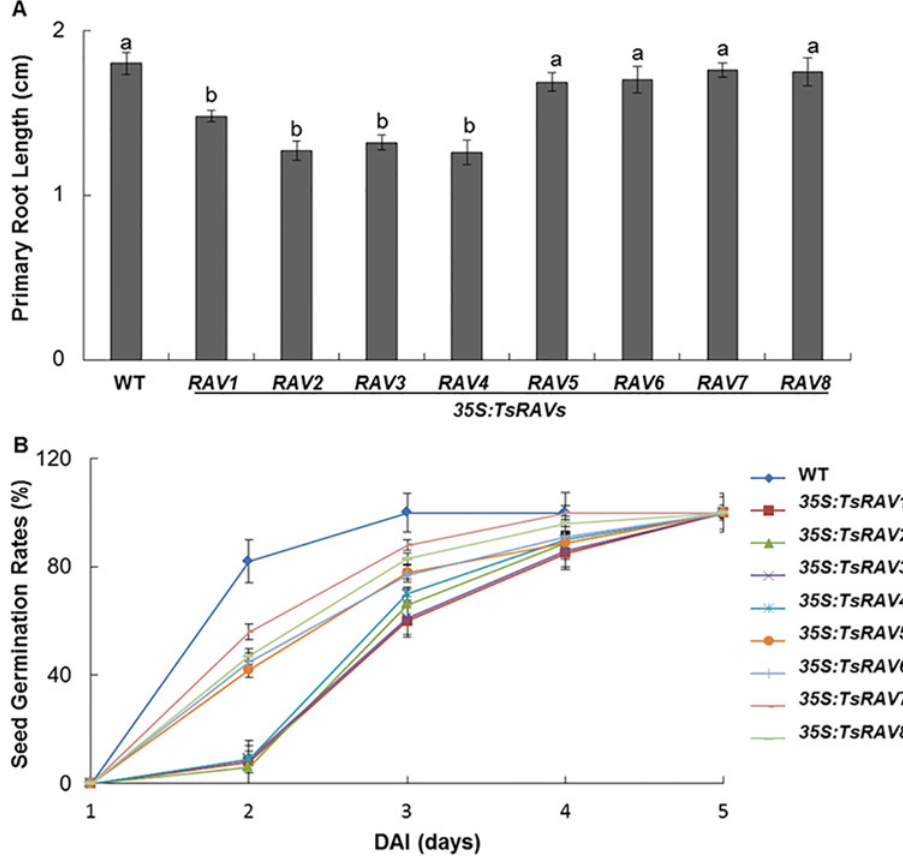
Fig 3. Phenotypic characterization of 35S : TsRAVs transgenic Arabidopsis plants under normal conditions. (A) Primary root length of 7-d-old 35S : TsRAVs transgenic Arabidopsis seedlings grown on 1/2 MS media. Each data bar represents the means ± SE of three replicates. More than 50 seedlings were measured for each replicates. Different letters indicate significant differences among means ( P < 0.05 by Tukey ’ s test). (B) Germination rates of 35S : TsRAVs transgenic Arabidopsis seeds during a 5-day period on normal 1/2 MS media. Each data bar represents the means ± SE of three replicates. More than 100 seeds were measured in each